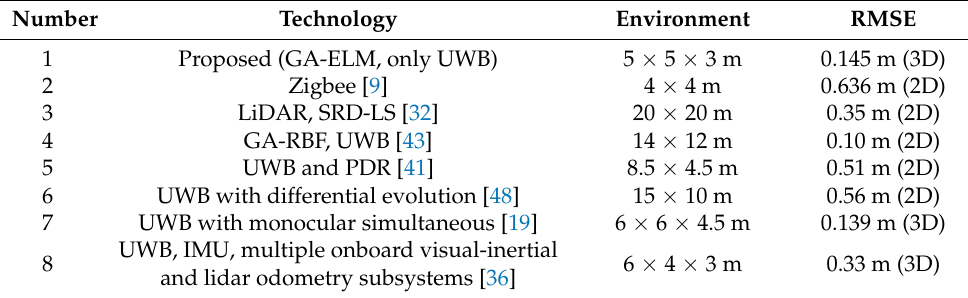
Table 6. The comparison of the positioning accuracy of different methods.